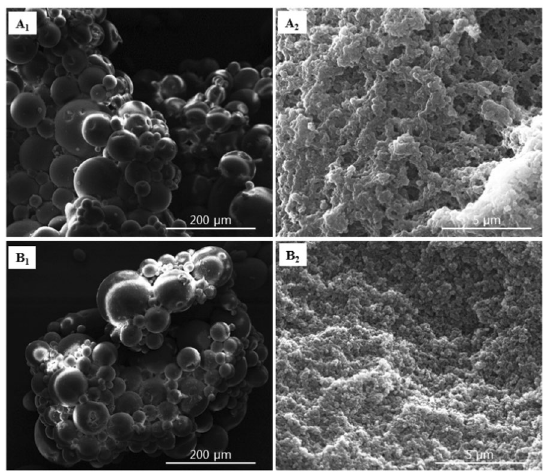
Fig. 2 SEM images of the synthesized resins of OL‑PS‑DVB ( A ) and MA‑PS‑DVB ( B )